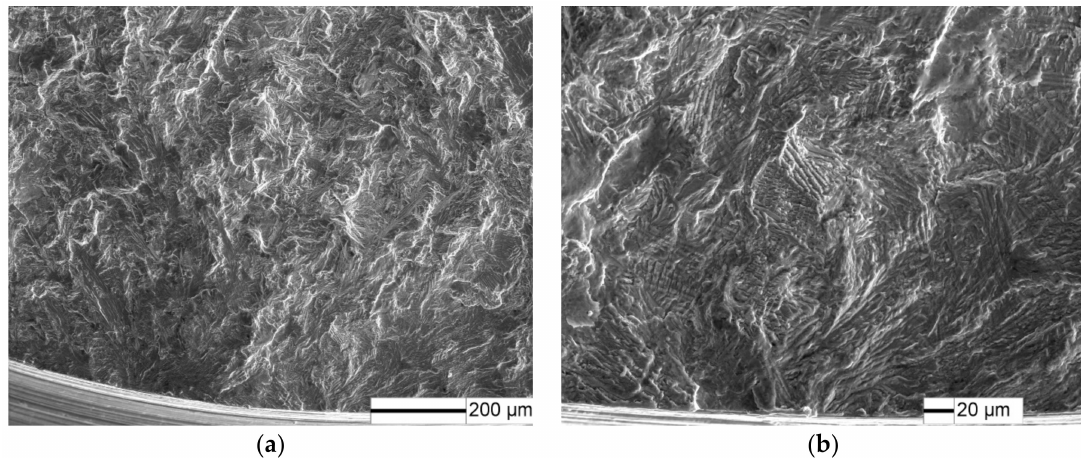
Figure 11. Fracture surface for the notch specimens at σ = 250 MPa and N = 3.8 × 10 5 cycles: ( a ) fatigue crack initiation site, and ( b ) crack initiation morphology.